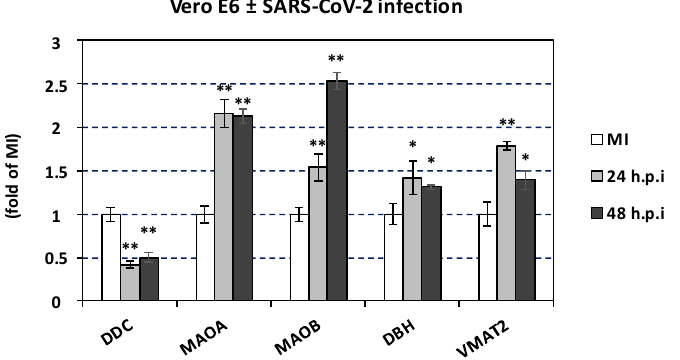
Figure 9. Effect of SARS-CoV-2 infection on DDC , MAOA , MAOB , DBH and VMAT2 gene expression in infected cultured cells. Vero E6 cells were infected or mock-infected (MI) with virions of the SARS-CoV-2 isolate 30–287 of lineage B1. The cells were lysed at 24 and 48 h post-infection. The mRNA levels of DDC , MAOA , MAOB , DBH and VMAT2 were quantified by RT-qPCR and the mRNA levels of the housekeeping gene YWHAZ was used for normalization. Bars represent mean values from three independent experiments in triplicates. Error bars indicate standard deviations. p -values were determined by the Student’s t -test. (MI: mock-infected cells) * p < 0.01 vs. MI, ** p < 0.0001 vs. MI.